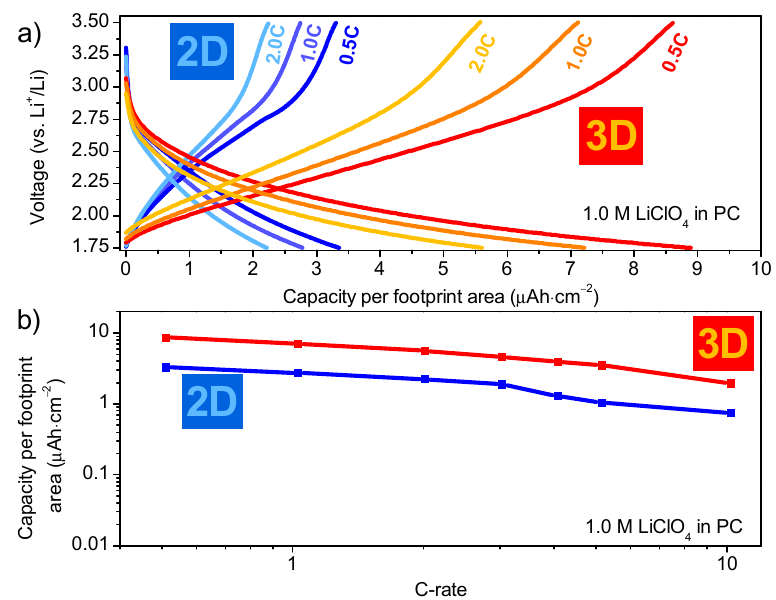
Figure 8. ( a ) Lithiation/delithiation curves; and ( b ) delithiation capacity-rate log-log plot of 2D (Pt) and 3D (TiN) WO 3 coated substrates, annealed at 500 °C for 10 min in static air. 2D samples were